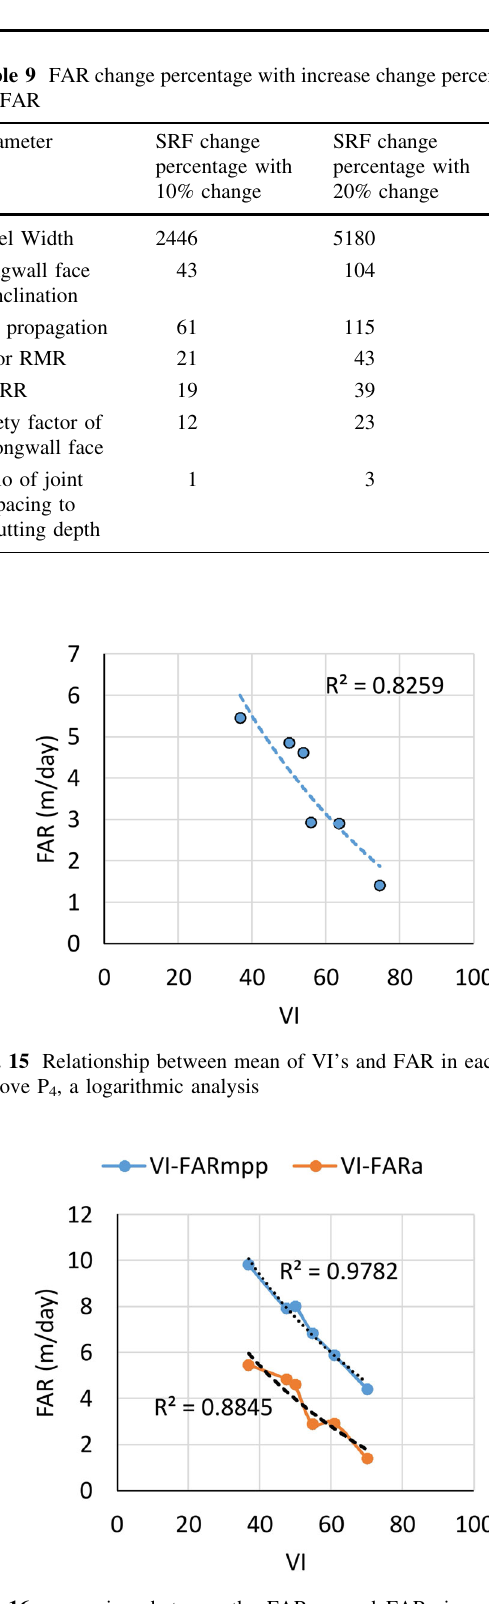
Fig. 16 comparison between the FAR mpp and FAR a in parvadeh-I coal mine